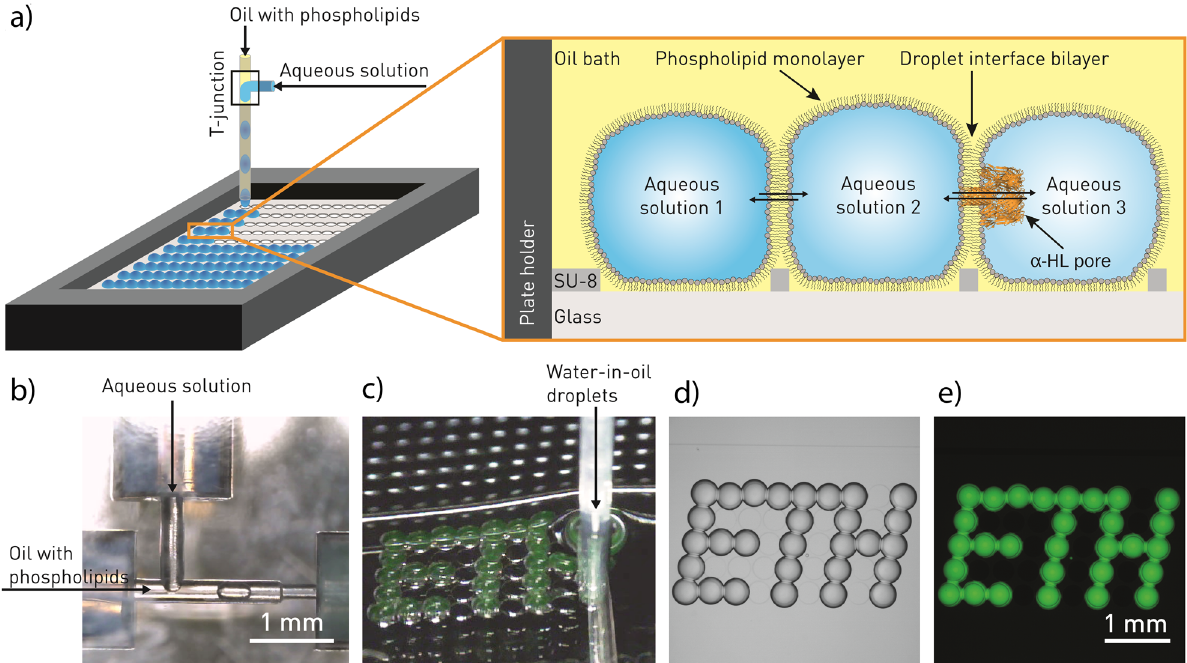
Fig. 1 Concept of the micro fl uidic platform for arti fi cial cell generation. a Schematics of droplet spotting and formation of the droplet interface bilayer (not to scale). Left: nanoliter droplets are formed in a micro fl uidic T-junction from an aqueous solution and oil with phospholipids. Thereafter, the droplets are transferred via a capillary and spotted on a glass plate with individual rows of cavities in close proximity. Phospholipids are present in the oil phase and self-assemble at the droplet interface while transitioning the capillary. Right: the spotted droplets are connected via a droplet interface bilayer. With our spotting platform, we can vary the content of the droplet next to each other and form droplet networks, here designated with aqueous solution 1-3. In addition, the pore forming toxin alpha-hemolysin ( α -HL) can be selectively added to allow exchange of small water-soluble molecules between droplets. The α -HL structure was obtained from the Protein Data Bank (rcsb.org) 38 . b Photograph of the T-junction for droplet formation. c Spotting